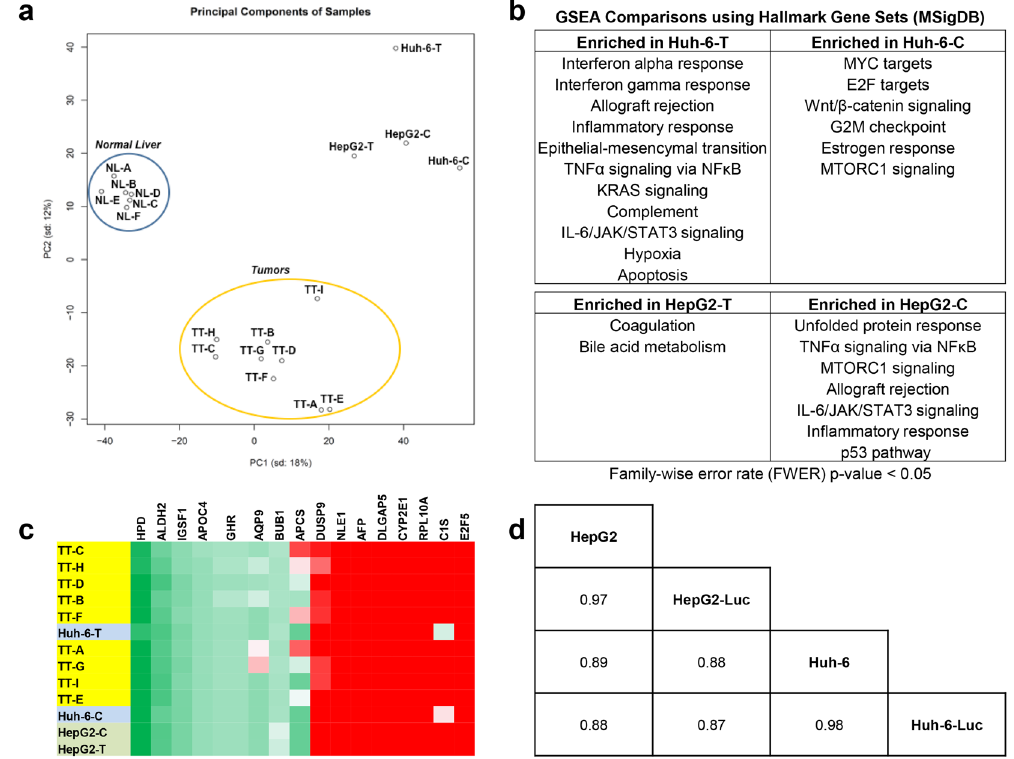
Figure 5. Transcriptome profiling of HB cell lines and tumor samples. ( a ) PCA of RNA sequencing data of two parental HB cell lines (HepG2-C, Huh-6-C) and two cell lines grown in vivo as xenograft tumors (HepG2-T, Huh-6-T), compared with RNA sequencing data of six normal liver samples and nine primary HB tumor samples. The two HepG2 samples and the Huh-6 sample grown in vitro form a cluster, indicating that their gene expression is similar to each other. The Huh-6 tumor sample is located far from the other clusters, showing that it has more transcriptome differences from the primary tumors and other cell line and xenograft samples. ( b ) GSEA to reveal transcriptome differences between cells grown in vitro and in vivo as xenograft tumors. ( c ) Molecular clustering of HB cell lines and tumor samples. Heat map analysis of 16-gene HB signature 27 in nine primary HB tumors (yellow) and four HB cell line and xenograft samples (HepG2 (green), Huh-6 (blue)), normalized to six normal liver samples. The cell line and xenograft samples show the C2 signature, which is associated with a worse prognosis. ( d ) Spearman correlation of 18571 HUGO genes to indicate gene expression similarities of two parental cell lines and two luciferase -transduced cell lines all grown in vitro